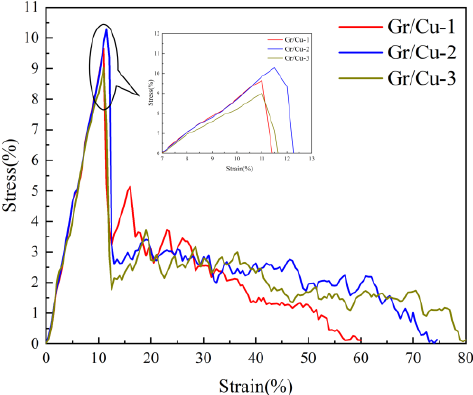
Figure 10. Tensile simulation stress–strain curves of Gr/Cu composites.